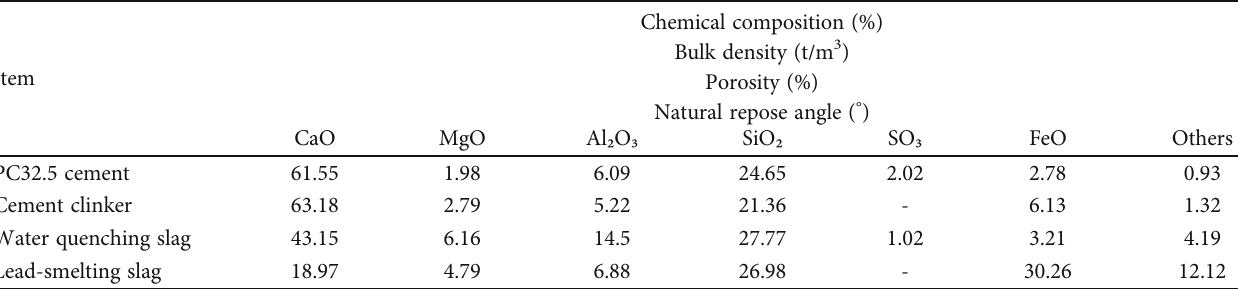
Table 2: Chemical composition of the binder